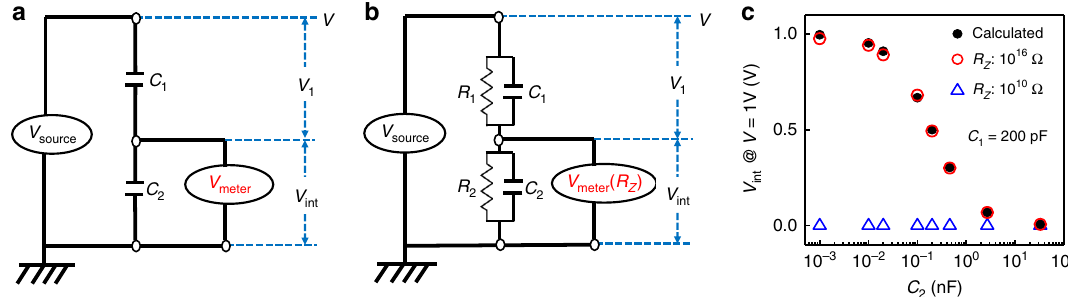
Fig. 1 Understanding and investigation of V int in PE/PE stacks. a Ideal and b actual equivalent circuits in the internal potential measurement in PE/PE stacks. C 1 /C 2 and R 1 /R 2 are the capacitance and insulating resistance of each FE-CAP. V 1 is the voltage applied on the top PE-CAP. R Z is the input impedance of V int measurement system. c V int , with V = 1 V and C 1 = 200 pF, as a function of C 2 from 1 pF to 33 nF for two cases using high input impedance system and conventional DC voltmeter. Only high impedance system enables to estimate the internal potential in DC mode